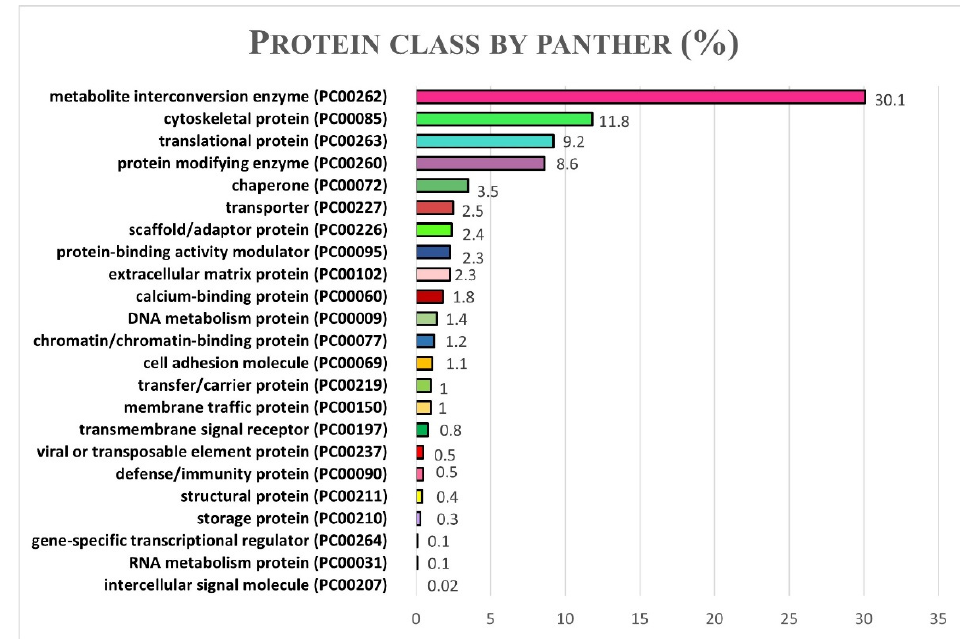
Figure 4. Protein Class of O. vulgaris skin mucus proteome identified by shotgun proteomics and categorized by PANTHER using the gene name as input for the software (http://pantherdb.org, accessed on 4 June 2022).